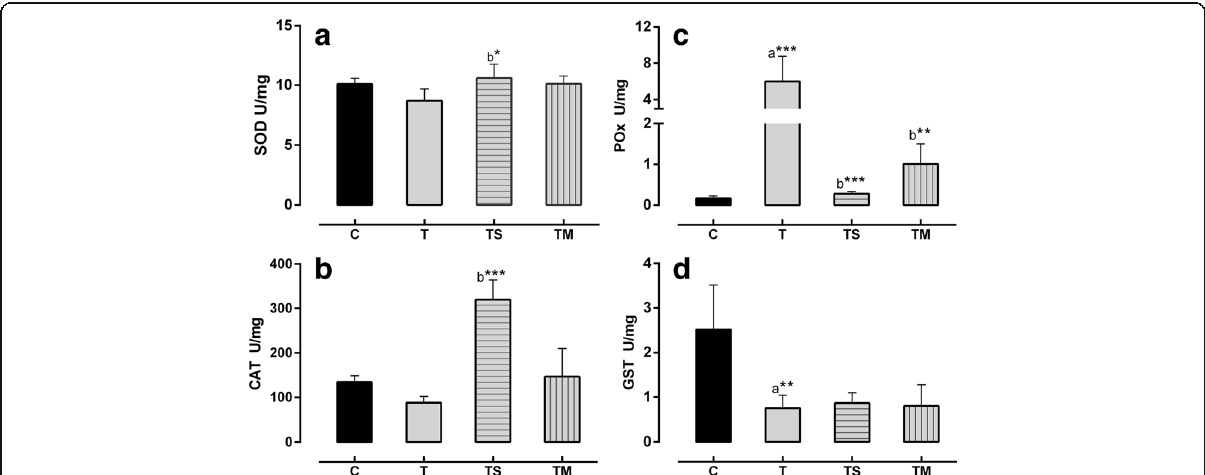
Fig. 1 Levels of antioxidant enzymes in hepatotoxic liver of rabbits induced by CCl 4 and treated by single clove garlic (SCG) extracts and multi clove garlic (MCG). a : SOD; b : CAT; c : POX; d : GST. Each value is mean ± SD ( n = 6). Activity of every enzyme was expressed as U/ mg protein.